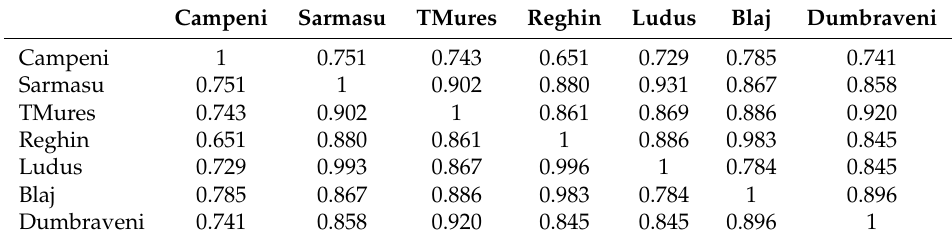
Table 3. The correlation matrix of the data sources from the six locations